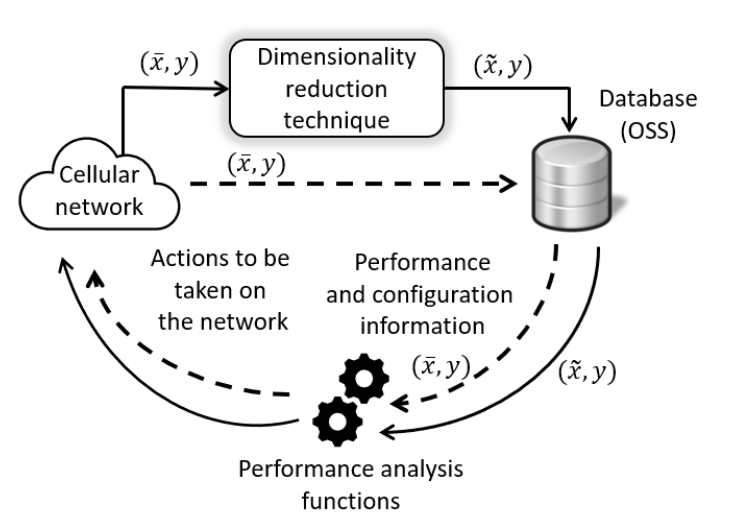
Figure 1. Comparison of a typical (dashed lines) and proposed (solid lines) schemes for network performance information gathering and use in performance analysis